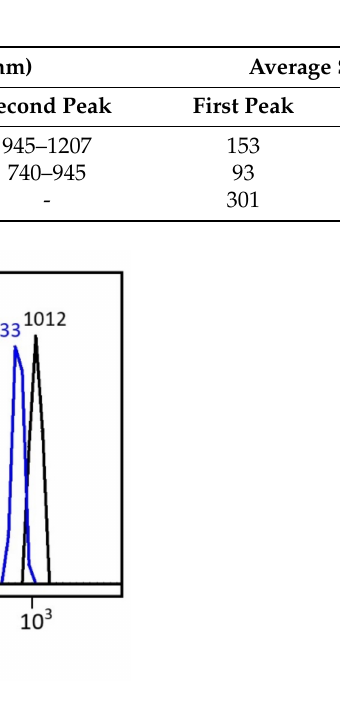
Figure 4. PSA results for ZVI particle size